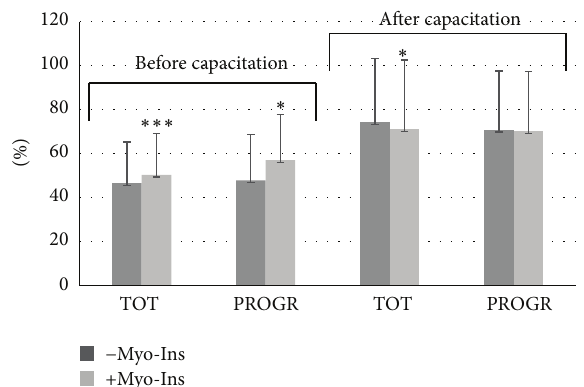
Figure 1: Sperm motility. Values are shown as mean ± SD. Statistical difference between pre- and post-Myo-Ins treatment: ∗ 𝑝 ≤ 0.05 ; ∗∗∗ 𝑝 ≤ 0.0001 .